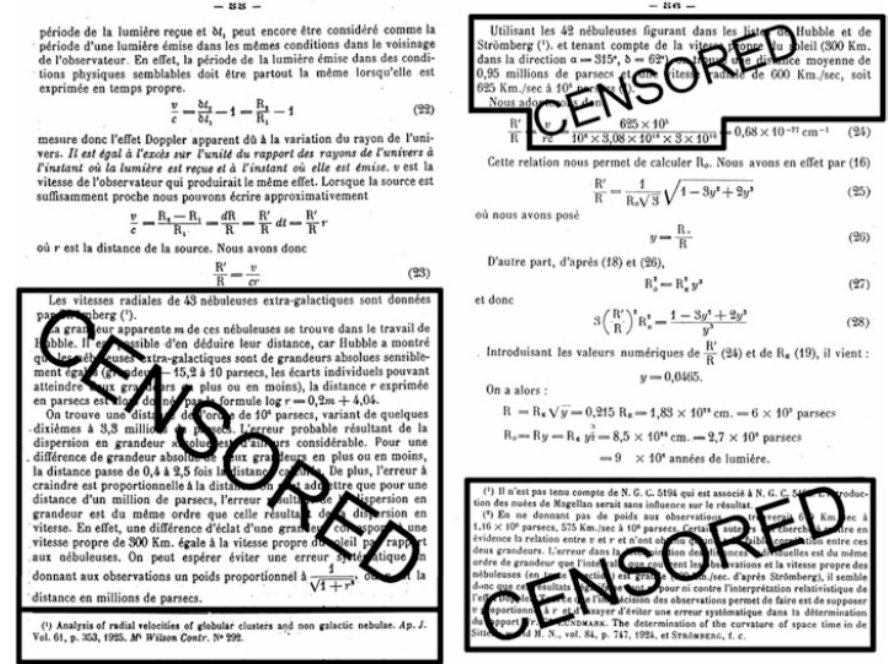
Figure 6. The sections on Lemaître’s 1927 article that were not included in the English translation published in 1931. It is here suggested that the sections were censored away [18], but that is not the case.